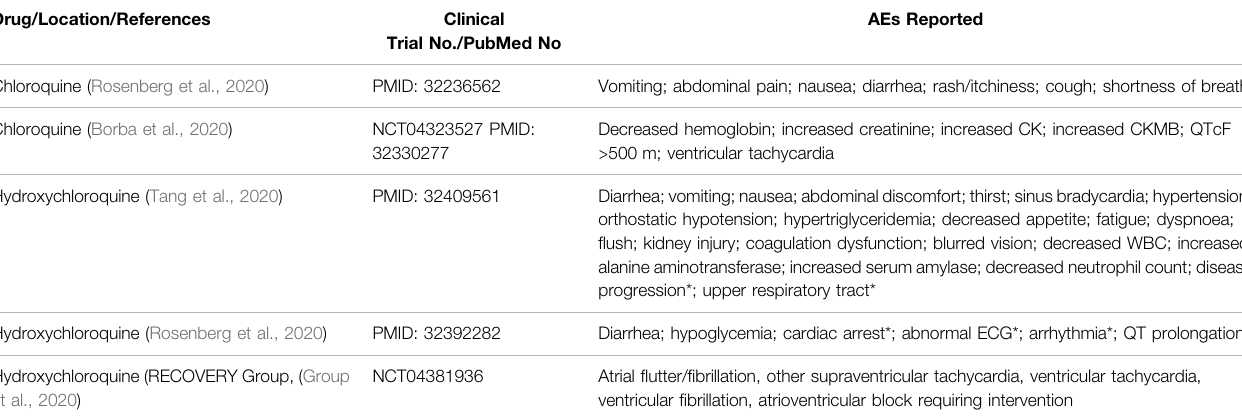
Figure 2 . The number of AEs under the Cardiovascular AE heading for CQ ( Figure 3A ) is much larger than the number of AEs under the Cardiovascular AE heading for HCQ ( Figure 3B ). Compared with the results from USPIs ( Figure 2 ), more cardiovascular AE term types were reported in both CQ and HCQ cases in FAERS. This could be a result of increased use after the EUA and stimulated reporting after news of cardiac complications. HCQ reports doubled in the year 2020, 10,362 compared to